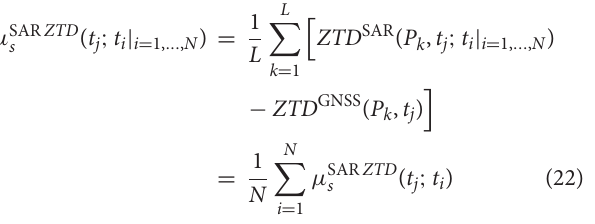
the resulting absolute map. In the TAE approach, the final SAR ZTD map at the slave epoch t j does not depend on the initial master epoch t M , but only on t i or, in the case of N > 1, on all the epochs used in the time average t i , i = 1, . . . , N